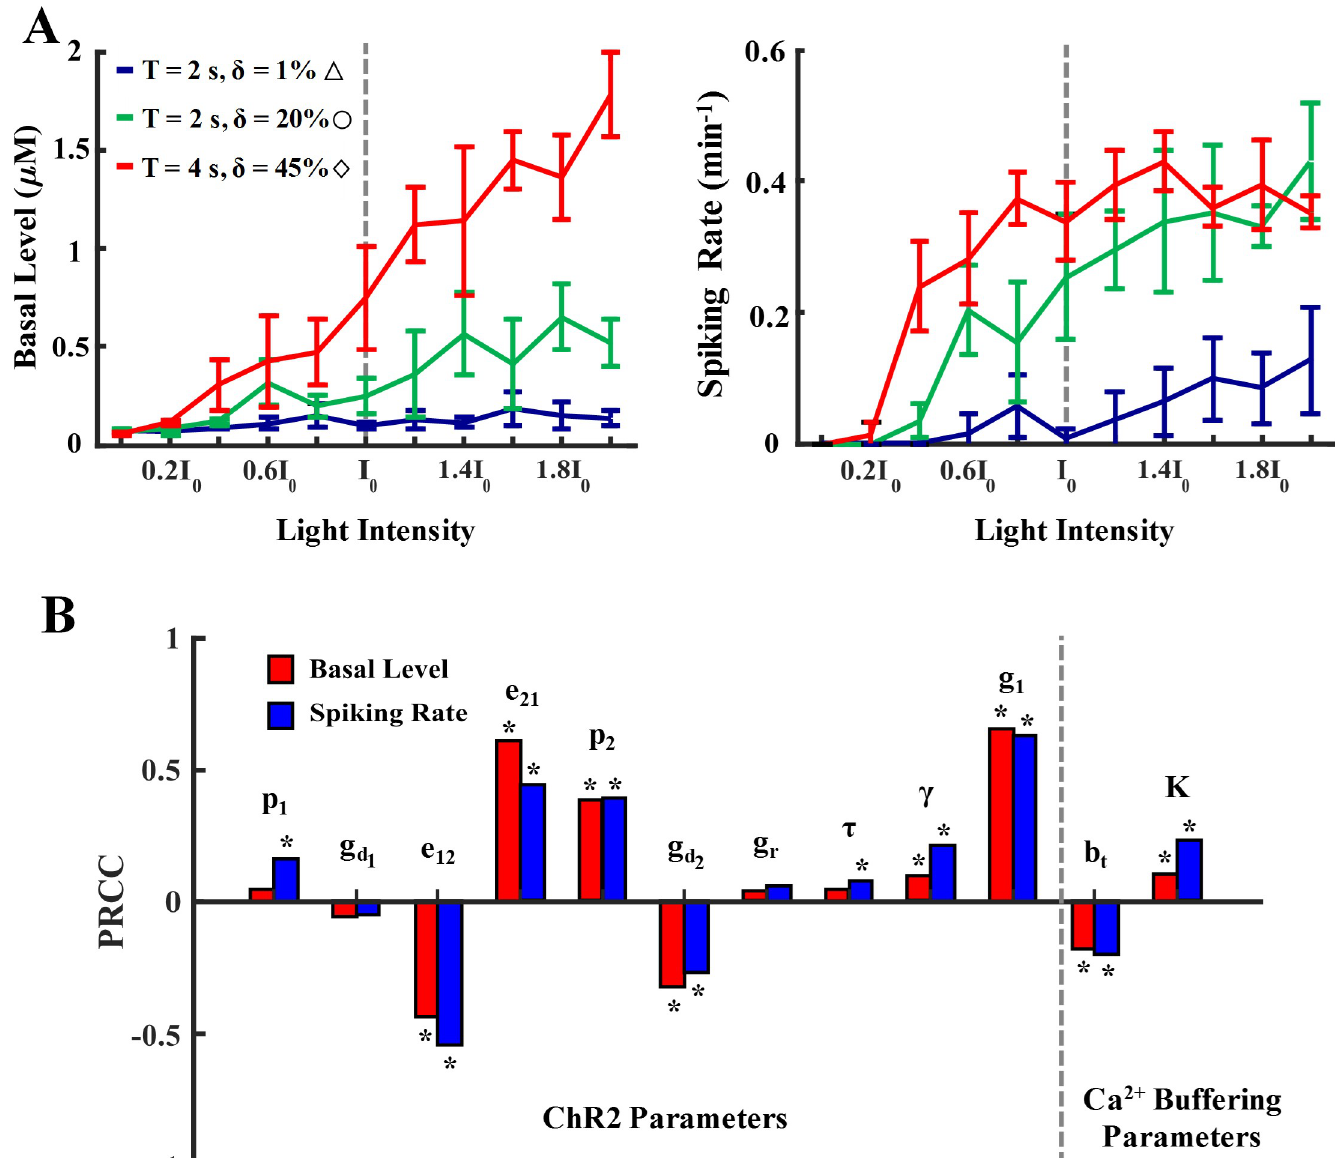
Fig 4. Model sensitivity to light intensity, Ca 2+ buffering, and ChR2 parameters. A) Effect of different light intensities and stimulation paradigms on the basal level and mean spiking rate of a ChETA-expressing astrocyte. Light intensity was varied as a fraction of the control value (I 0 ). Stimulation paradigms were selected based on the 45-min spiking rate heat map in Fig 3A for low ( △ ), medium ( � ), and high ( ^ ) activity regions. Data is shown as mean ± std (trials = 5). B) Global sensitivity analysis of the astrocytic Ca 2+ response to variations in ChR2 and Ca 2+ buffering parameters during light stimulation ( Δ : T = 2 s, δ = 1% (0.02 s)). Parameters were allowed to vary within a range (Table 2) and 1000 parameter sets were selected using Latin Hypercube Sampling (LHS) with uniform distribution. The partial rank correlation coefficient (PRCC) of each parameter was calculated as a measure of their effect on the basal level (red) and spiking rate (blue) of a ChR2-expressing astrocyte. � denotes statistically significant (p < 0.05) positive or negative